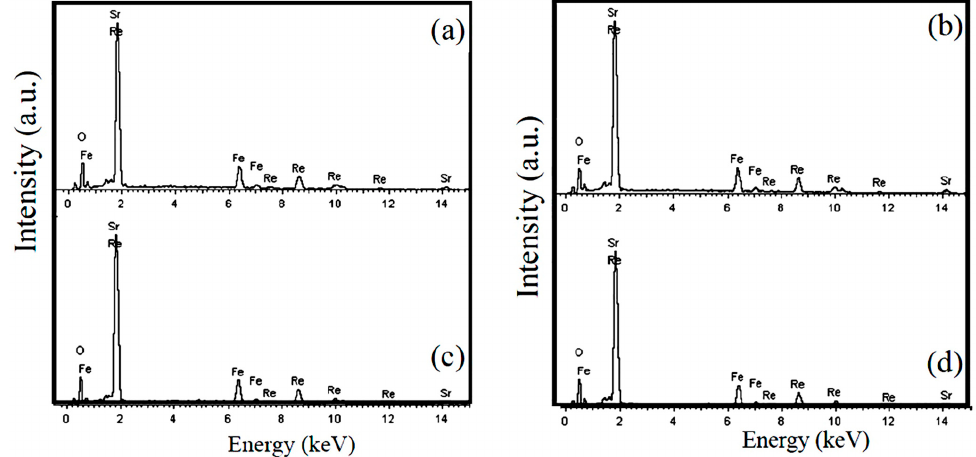
Figure 4. EDS spectra collected in a mapping mode for samples A–D. ( a ) sample A, ( b ) sample B, ( c ) sample C, and ( d ) sample D.